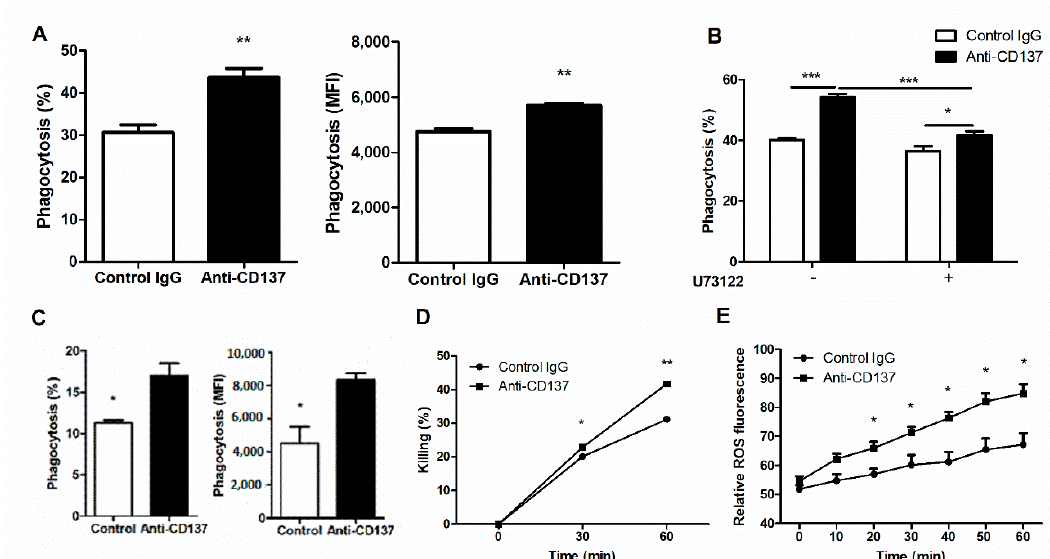
Figure 4. CD137 stimulation enhances the phagocytic and fungicidal activities of neutrophils. ( A ) In vitro analysis of phagocytosis. Purified neutrophils were preincubated with anti-CD137 mAb (5 µ g/mL) for 1 h and challenged with opsonized, FITC-labeled HK C. albiccans (MOI = 10) for 20 min. The percentages and MFIs of FITC-positive neutrophils were presented for the extent of phagocytosis ( n = 5 mice per group). ( B ) Neutrophils were pretreated with 2 µ M U73122 (PLC inhibitor) 2 h before antibody treatment. The percentages of FITC-positive neutrophils were calculated using FACS. ( C ) In vivo analysis of phagocytosis. WT mice were intraperitoneally injected with 200 µ g of anti-CD137 or control rat IgG antibody 1 h before challenge with FITC-labeled HK C. albicans . Cells harvested from the peritoneum were stained and percentages of phagocytosis were determined by counting CD11b + Ly6G hi neutrophils containing C. albicans . The MFIs was also presented for the extent of phagocytosis ( n = 5 mice per group). ( D ) Fungicidal assays for neutrophils primed with anti-CD137 or control antibody. ( E ) Measurement of ROS in neutrophils primed with anti-CD137 or control antibody. Results are representative of 3 experiments ( n = 3 per group). * p < 0.05; ** p < 0.01; *** p < 0.001 between the two groups or between the indicated